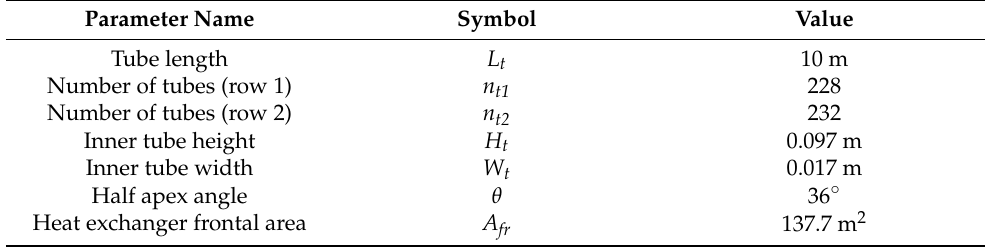
Table 1. Heat exchanger specifications.